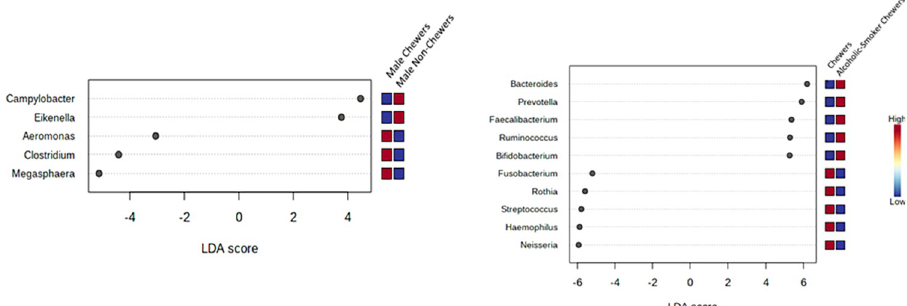
Fig 8. a. Lefse Plots: Genus-level oral microbiome significant features composition of Betel quid (Males) Chewers Vs. Non-Chewers; b . Betel quid Chewers Vs. Alcoholic-Smoker Chewers.